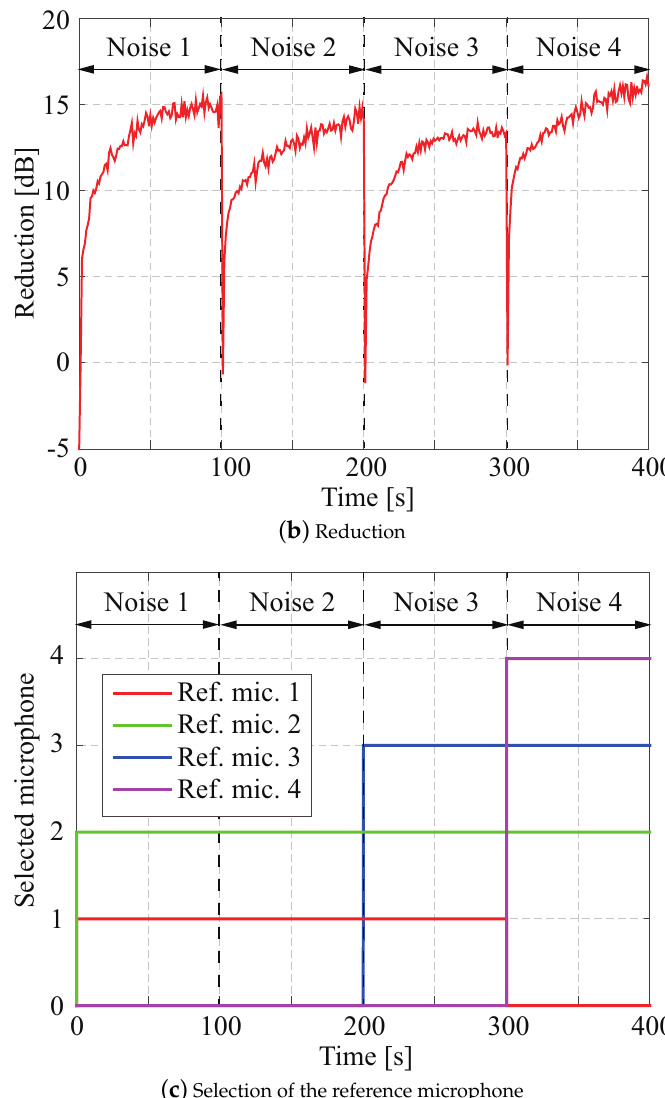
Figure 13. Noise reduction performance in cases where arrival direction of noise is changed by using optimal reference